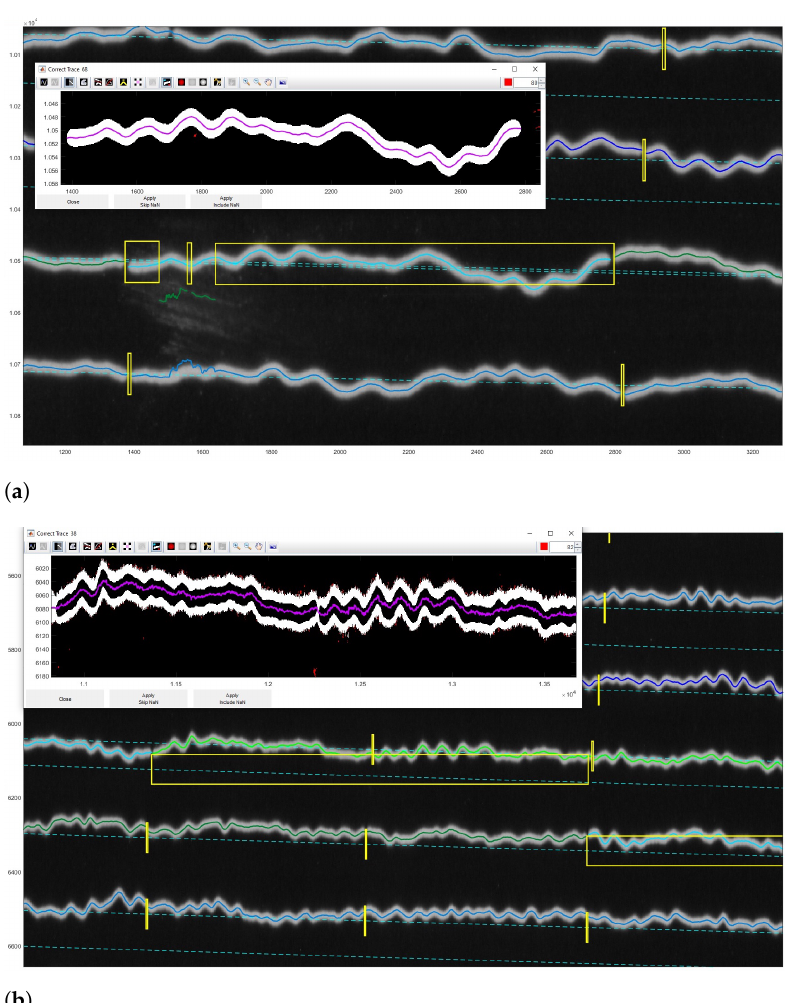
Figure 15. Correcting trace for the selected segments. ( a ) Merging the trace initially broken into the three separate parts (three small yellow boxes). ( b ) Reclassification of the selected segment and digitising the centroid of the trace line.